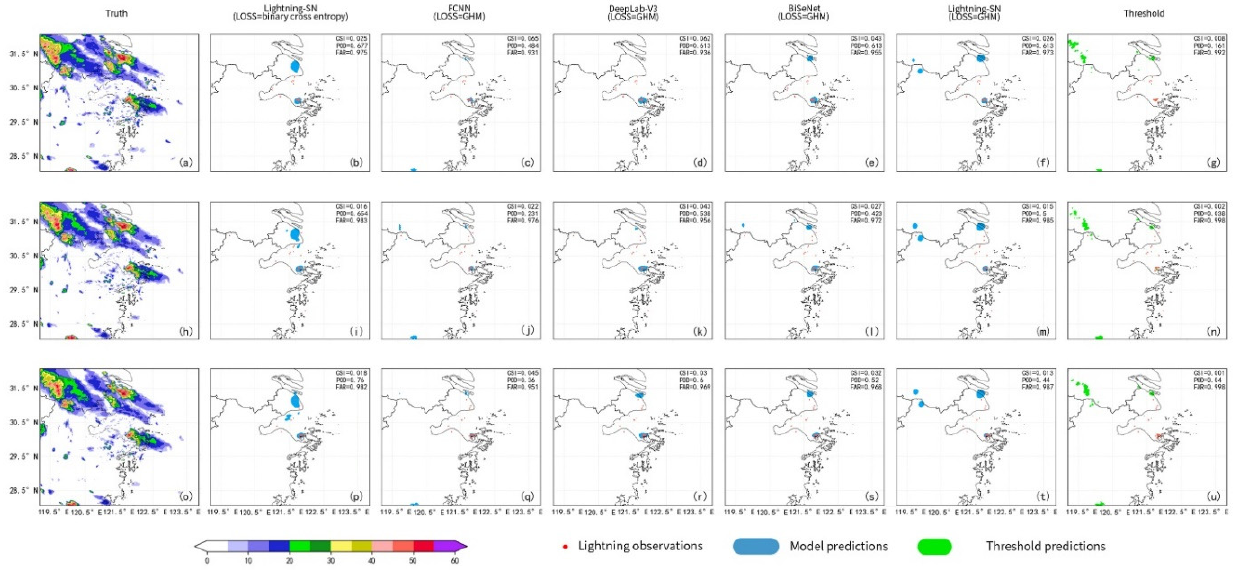
Figure 8. Similar to Figure 6, but for lightning identification from 16:00 to 16:18 on 10 July 2021. ( a – g ) 16:00–16:06; ( h – n ) 16:06–16:12; ( o – u ) 16:12–16:18.